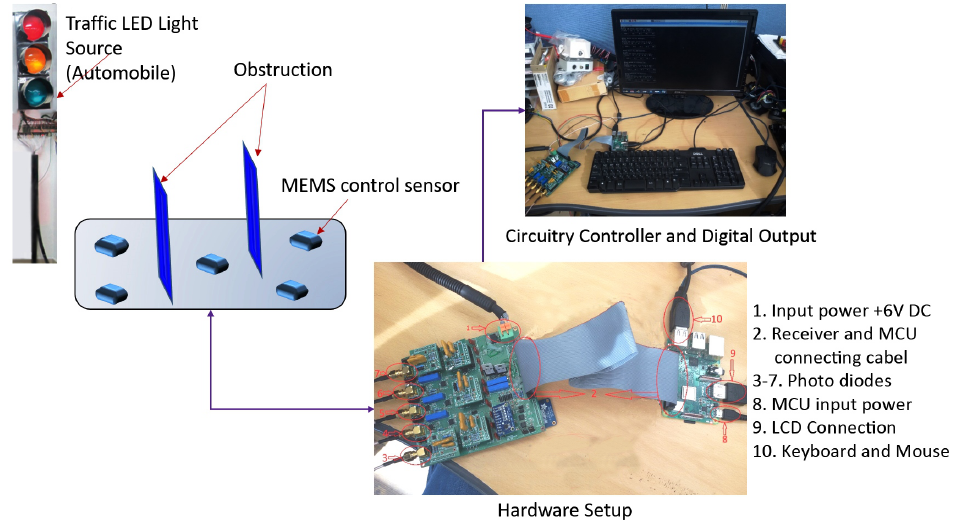
Figure 4. Proposed V-VLC receiver design’s hardware